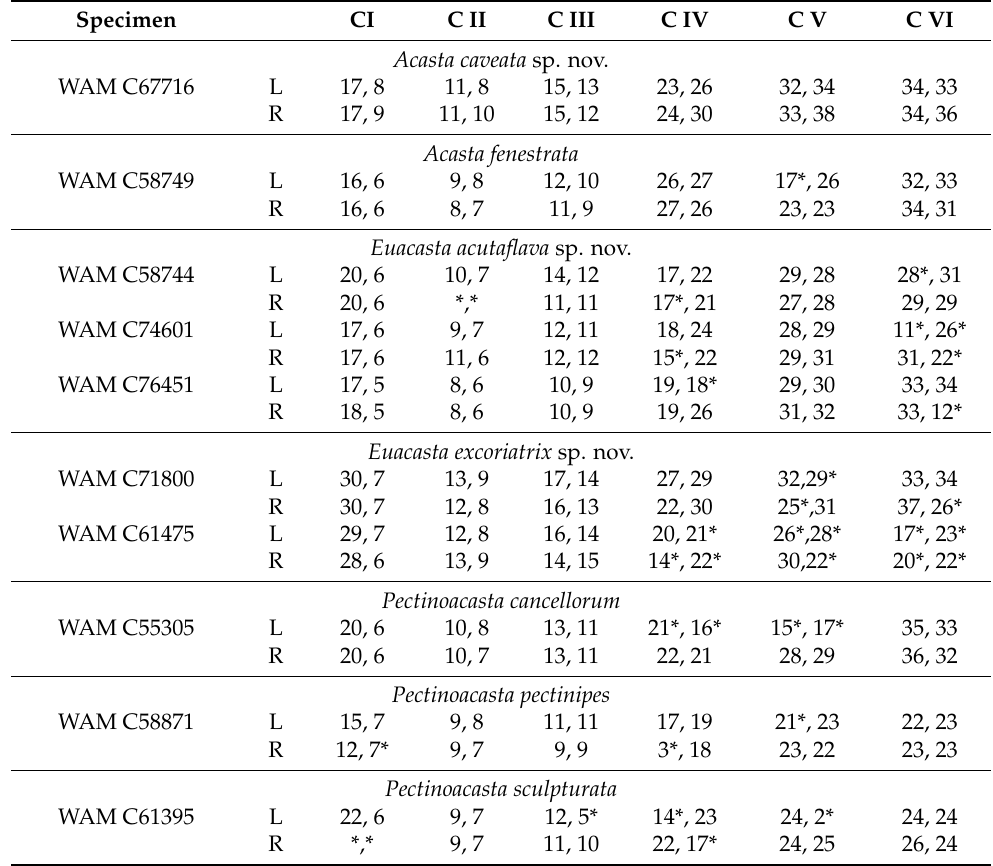
Table 2. Number of segments on each left (L) and right (R) cirrus (CI–CVI; anterior, posterior ramus) of species described herein, * denotes damaged cirrus.